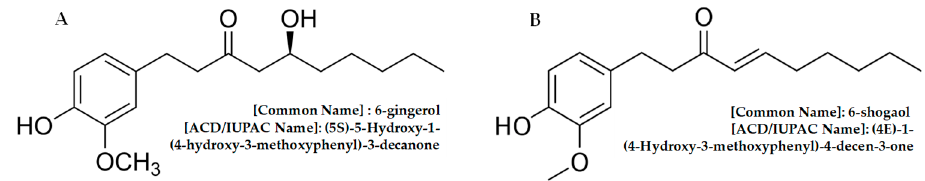
Figure 4. Chemical structures of ( A ) 6-gingerol and ( B ) 6-shogaol. Structures were made with free ChemSpider software [22].